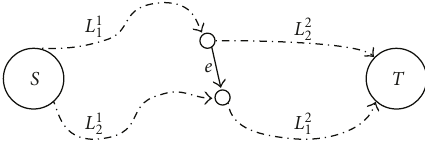
Figure 6: P 1 , P 2 shares the edge e